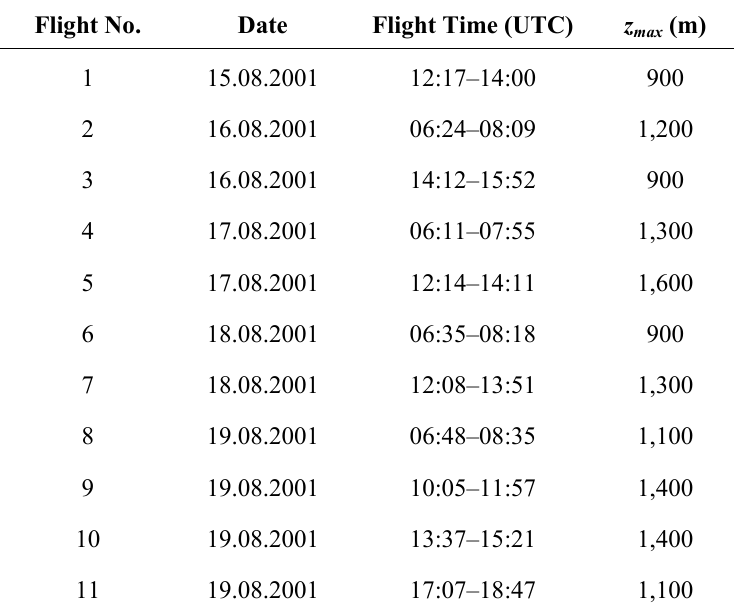
Table 2. Overview of all performed vertical profile flights. z Flight